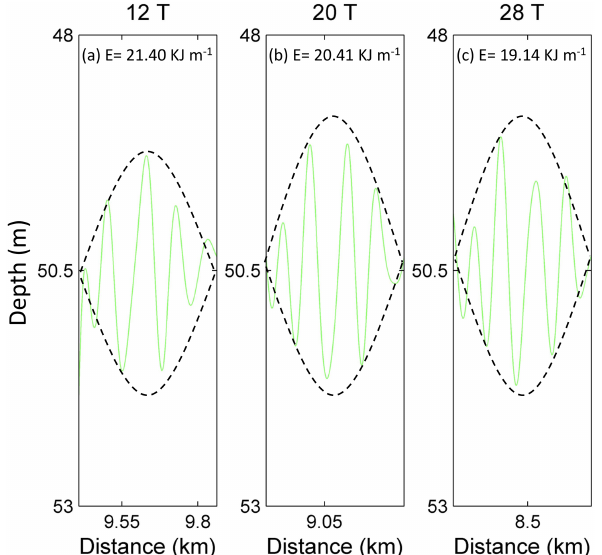
Figure 16. The envelopes of the amplitude-modulated wave packet in case O5 ( (cid:49) = 0) at (a) 12 T , (b) 20 T and (c) 28 T , where the mean density isopycnals of the upper and lower layers (green line) are plotted.